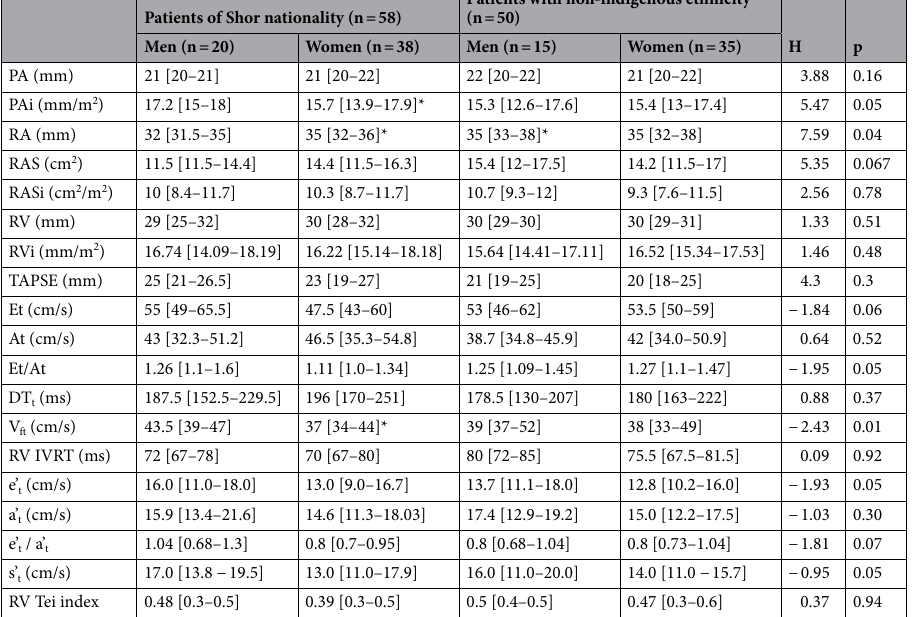
Table 3. Right ventricular and atrial parameters in hypertensive patients of various ethnic groups. PA— pulmonary artery diameter; RAS—right atrium square; RV—right ventricle; TAPSE—tricuspid annular plane systolic excursion; RA—right atrium; mPAP—mean pulmonary artery pressure; SPAP—systolic pulmonary arterial pressure; E t —early transtricuspid diastolic filling; A t —late transtricuspid mitral diastolic filling; e’ t — early diastolic tricuspid annular tissue velocity; a’ t —late diastolic tricuspid annular tissue velocity; s’ t —systolic tricuspid annular tissue velocity; * p < 0.05 compared with Shor men.